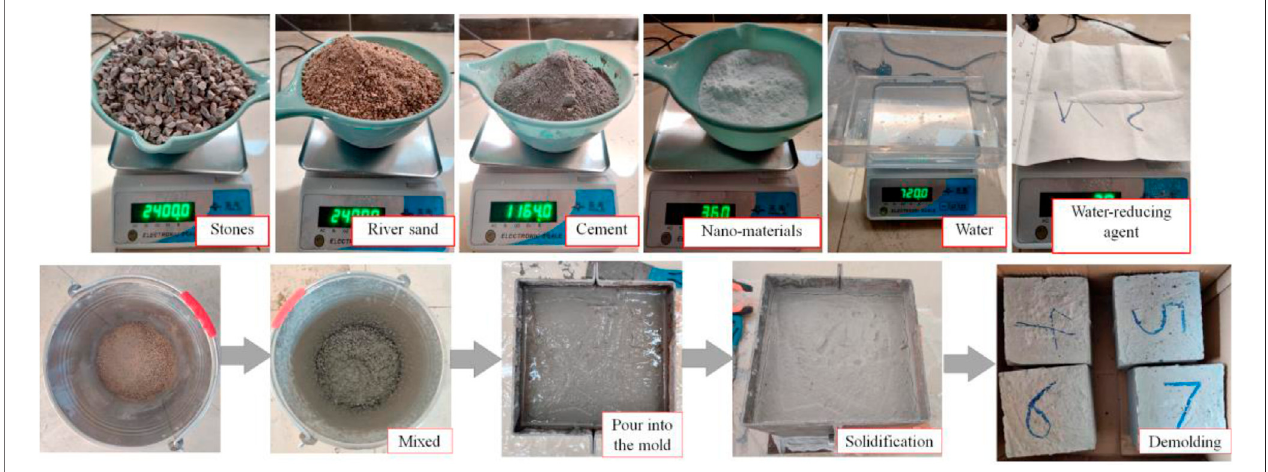
FIGURE 1 | Sample preparation